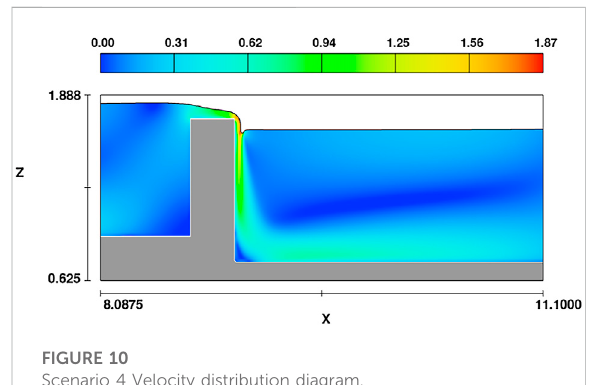
FIGURE 10 Scenario 4 Velocity distribution diagram.